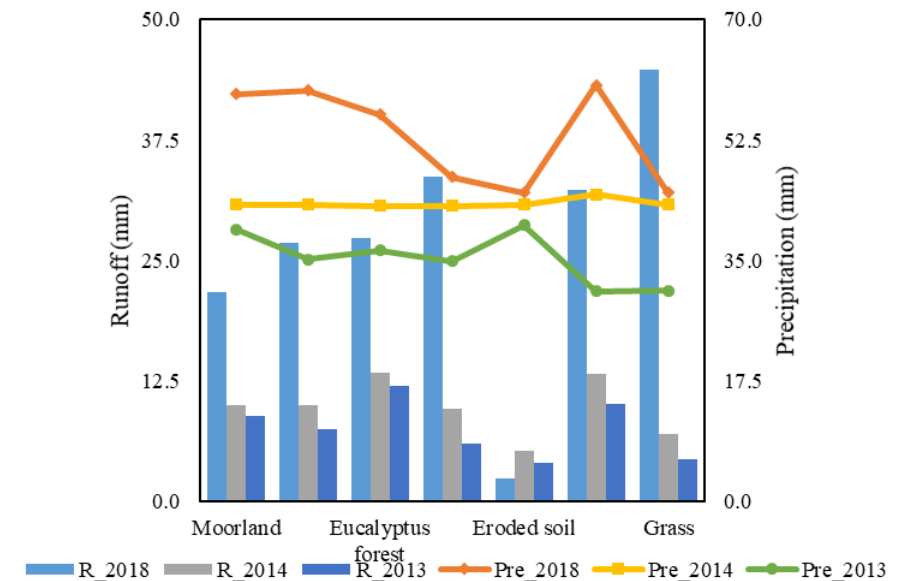
Figure 4. Precipitation-runoff relationship of the Chibunga river